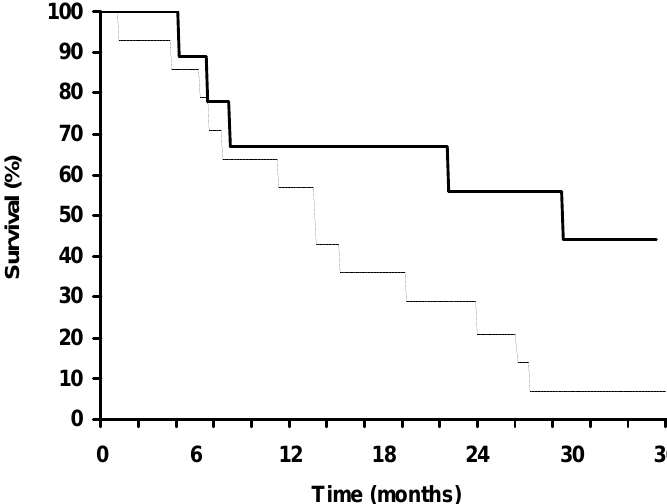
Figure 1.: Survival of patients with stage I-IIa esophageal carcinoma according serum neopterin concentrations. Shown are the Kaplan-Meier survival curves of patients with serum neopterin < 6.5 nmol/L (bold line) and > 6.5 nmol/L (dashed line). Median survival of patients with serum neopterin < 6.5 nmol/L was 29.4 months compared to 13.7 months in patients with neopterin concentrations > 6.5 nmol/L (log-rank test p =